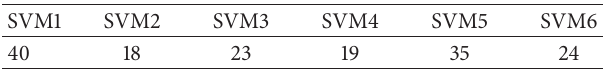
Table 5: The number of support vectors.